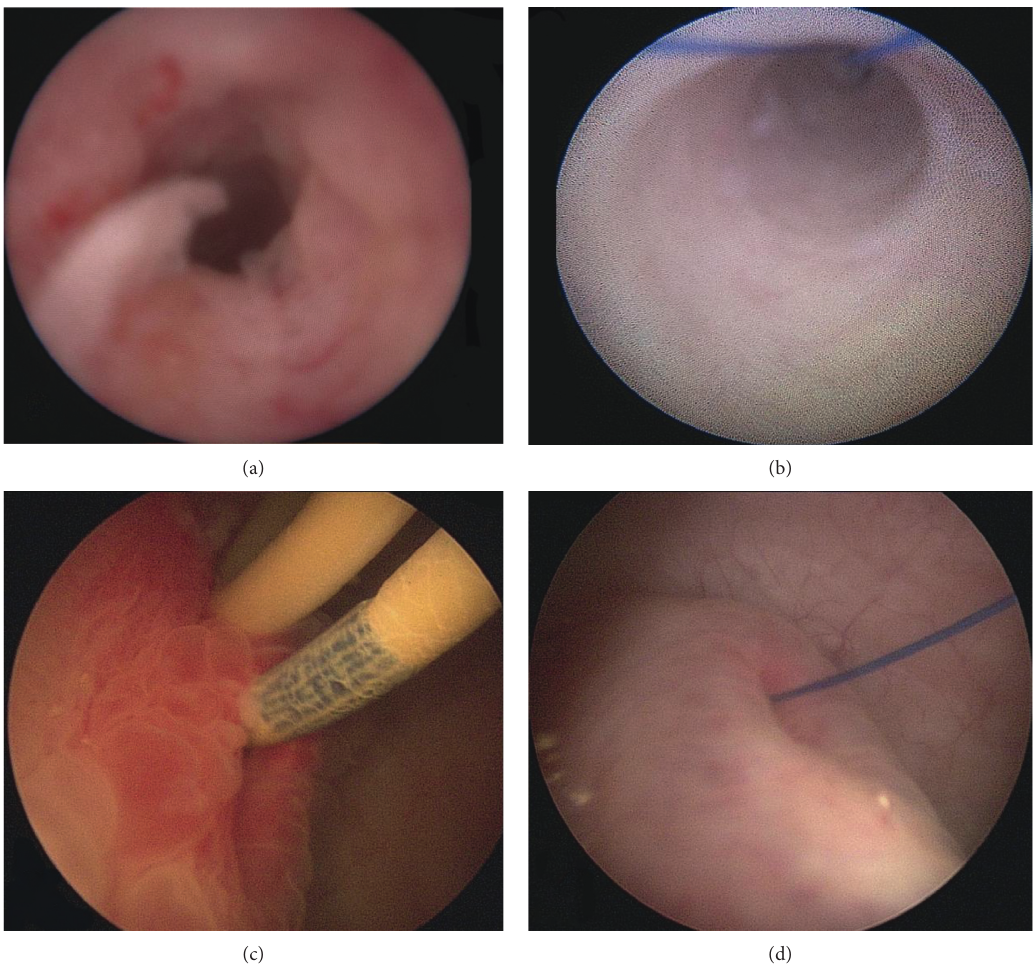
Figure 2: Endoscopic appearance. (a) Appearance of the inflamed ureter around the double-pigtail stent after stent removal. (b) Dilation of the ureter without inflammation after pigtail-suture stent implantation. (c) Inflamed ureteral orifice around the double-pigtail stent. (d) Dilated ureteral orifice without inflammation after pigtail-suture stent